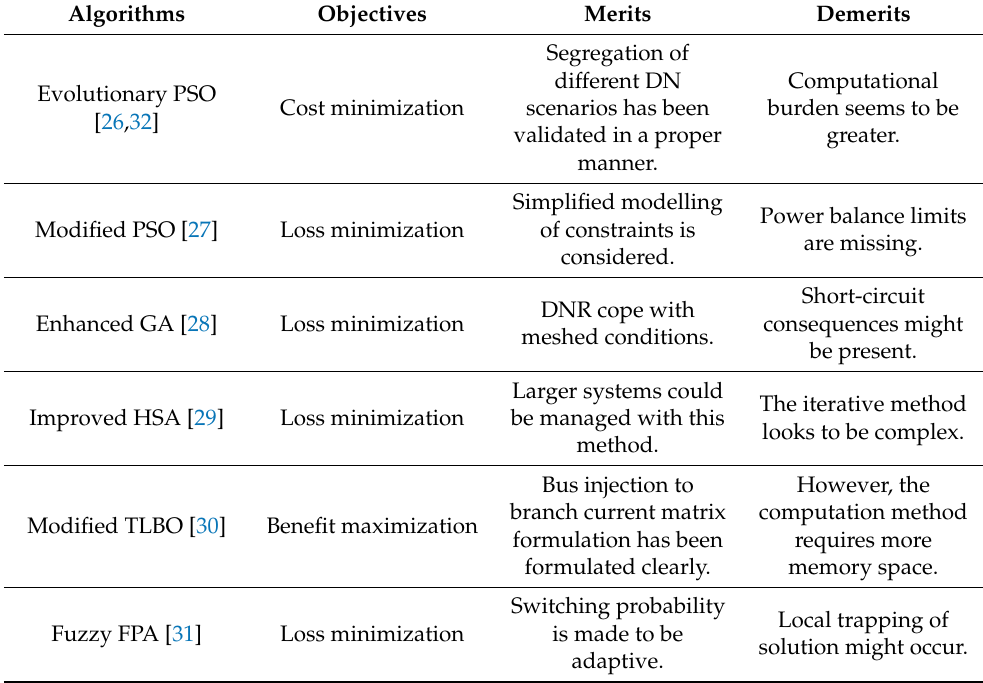
Segregation of Computational different DN burden seems to be scenarios has been greater. validated in a proper manner. Simplified modelling Power balance limits of constraints is are missing. considered. Short-circuit DNR cope with consequences might meshed conditions. be present. Larger systems could The iterative method be managed with this looks to be complex. method. Bus injection to However, the branch current matrix computation method formulation has been requires more formulated clearly. memory space. Switching probability Local trapping of is made to be solution might adaptive.